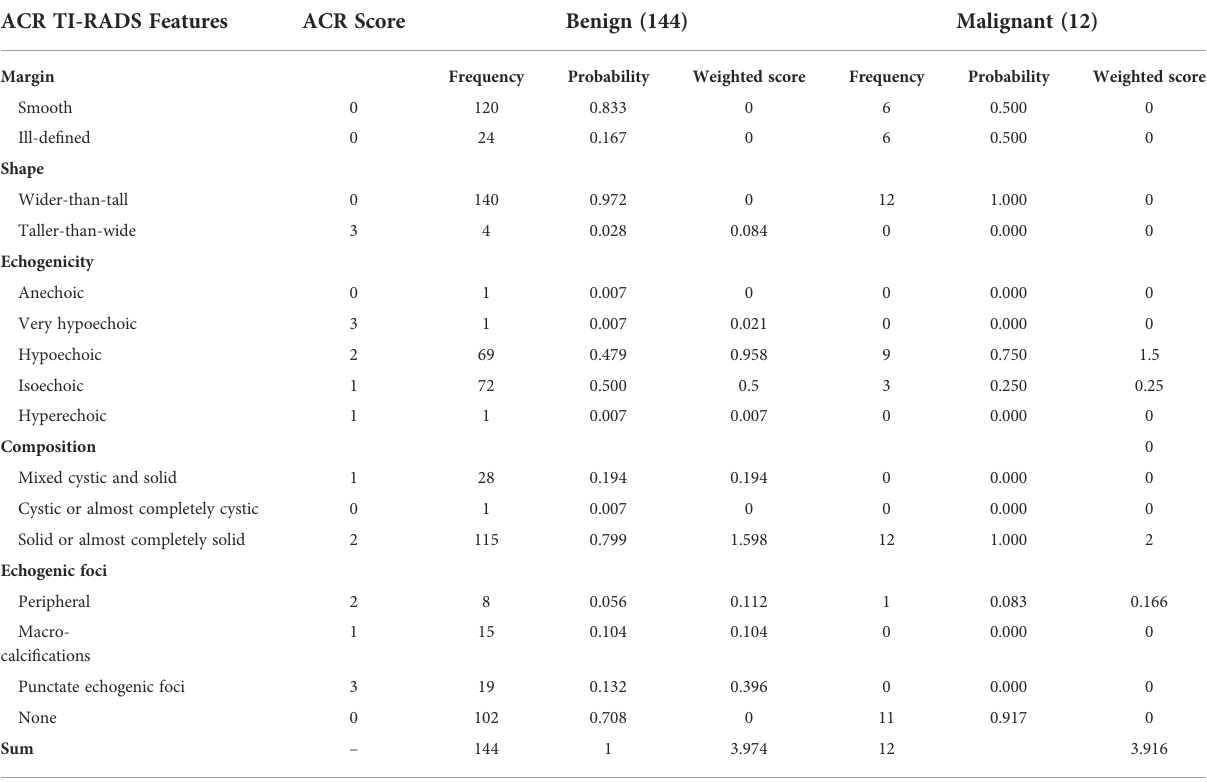
TABLE 4 Correlation of ultrasonographical features with nodular benignity and malignancy for which the AI system made correct diagnoses but failed by at least two of the three radiologists participating in the evaluation comparison study. ACR TI-RADS Features